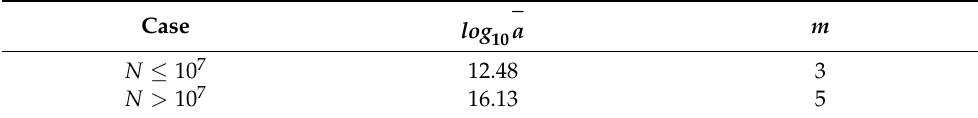
Table 4. Parameters of S-N curve.